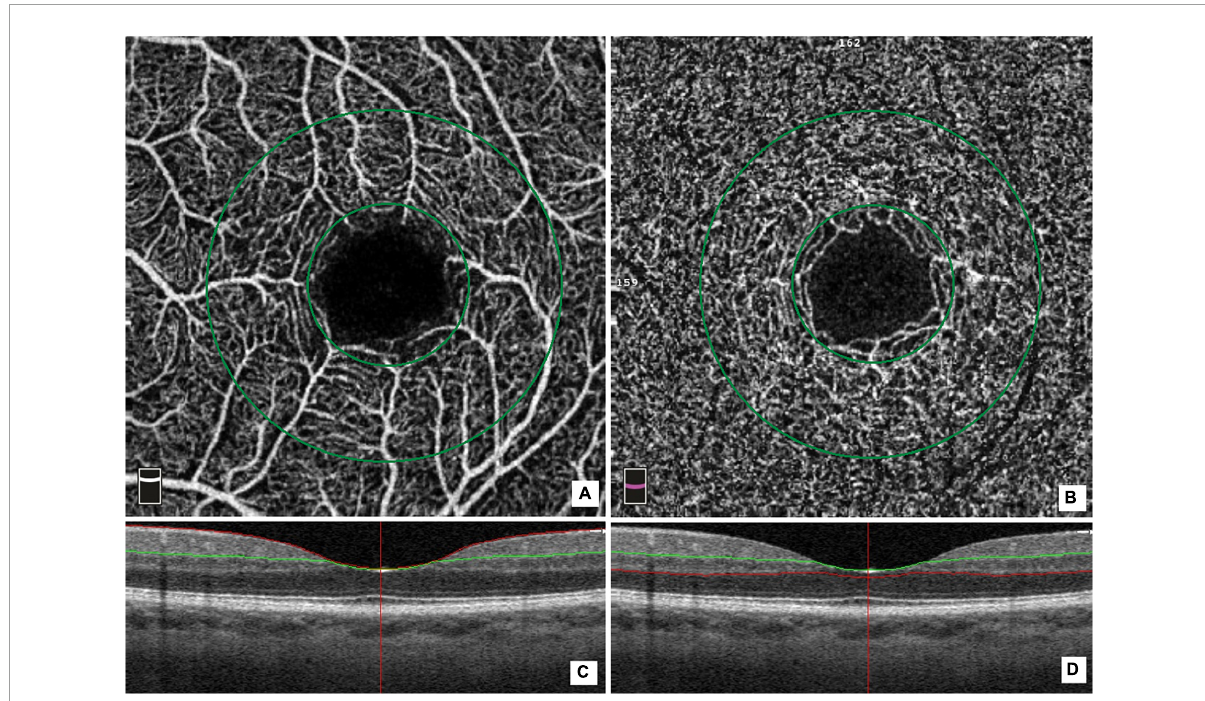
FIGURE1 Optical coherence tomography (OCT) angiographic images of the macular region and corresponding structural OCT scans. The macular vessel density measurement included measurements of the superficial (A) and deep vascular (B) plexi in an area measuring 3 mm × 3mm. The macular area was divided into a foveal and a parafoveal area between two concentric circles with a 1 and 3 mm diameter, respectively (A,B) . The colored lines (red and green) in horizontal OCT B-scans show segmentation lines defining the different depths in the retinal tissue. The superficial capillary plexus is segmented from approximately 3 µ m below the inner limiting membrane to 15 µ m below the inner plexiform layer (IPL) (C) . The deep capillary plexus is segmented from 15 µ m below the IPL to 70 µ m below the IPL (D)